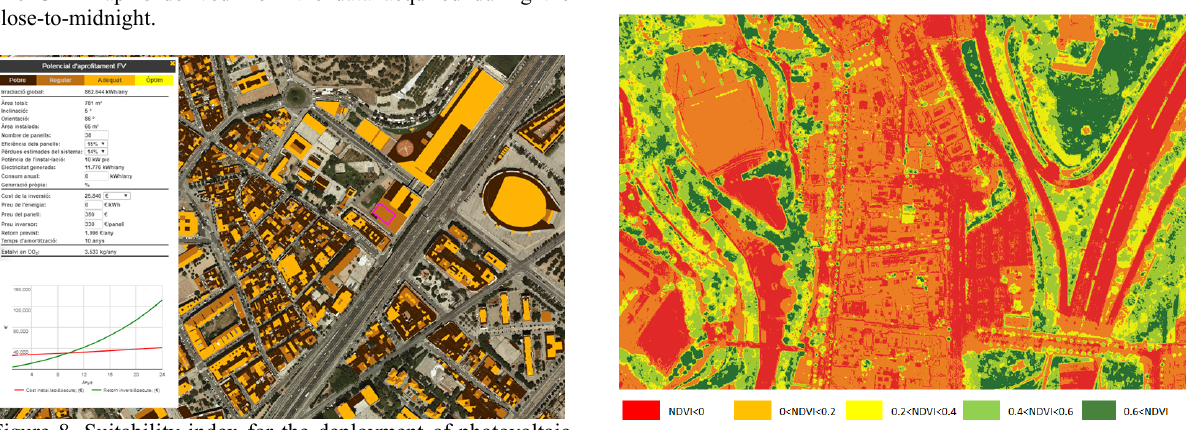
Figure 10. Urban green (NDVI)